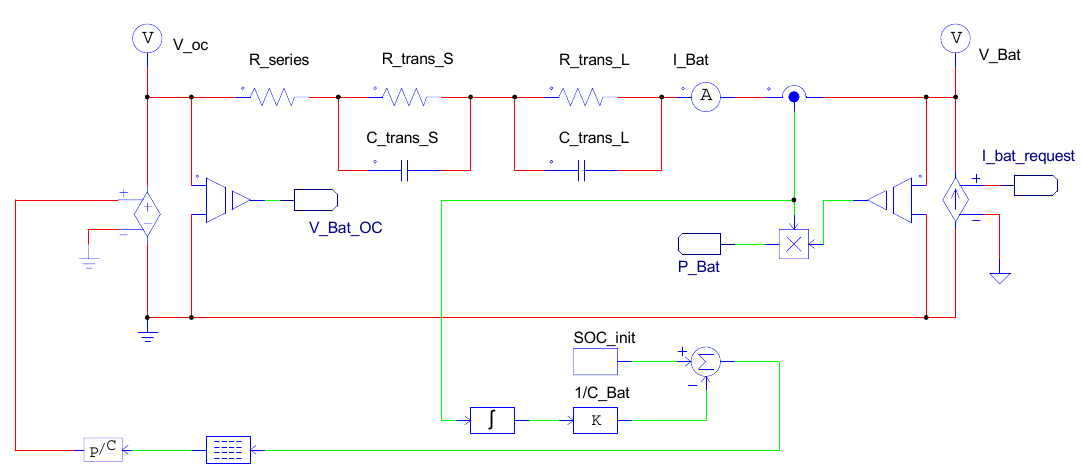
Figure 11. Thevenin-based model of one energy storage module.